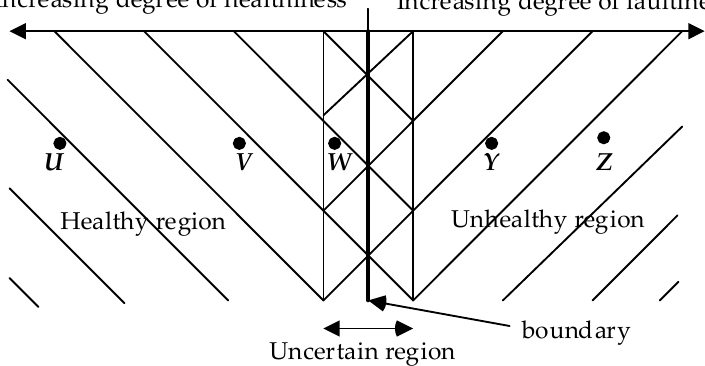
Figure 1. An illustration diagram showing the concept of degree of healthiness and faultiness.